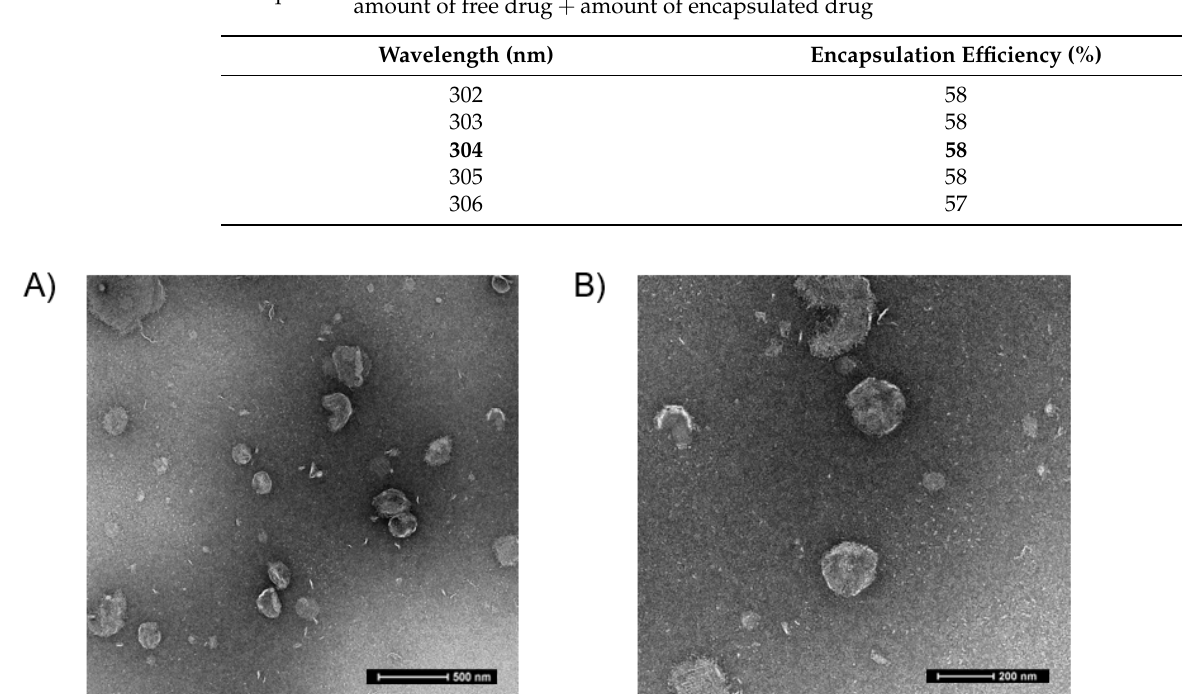
Table 2. Determination of encapsulation efficiency (%). The encapsulation efficiency of the liposomes